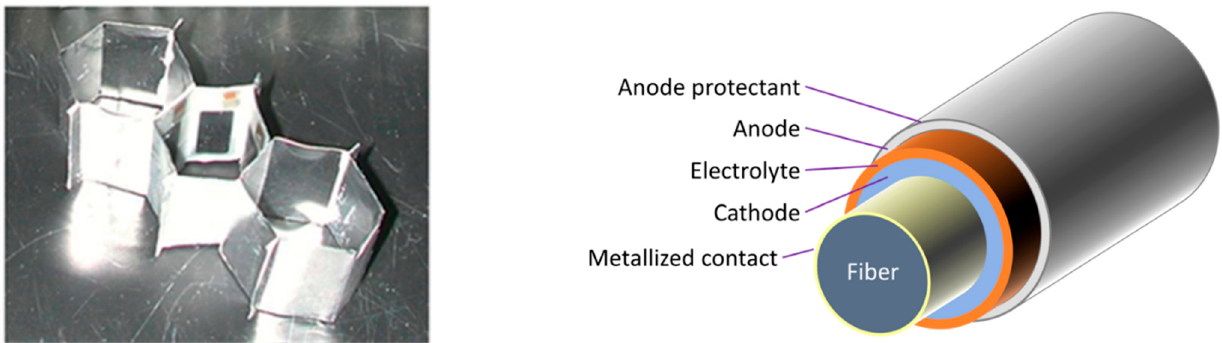
Figure 4. Examples of type ‐ II structural batteries: planar [49] ( left ) and coaxial configurations, after [50] ( right ). after [50] ( right